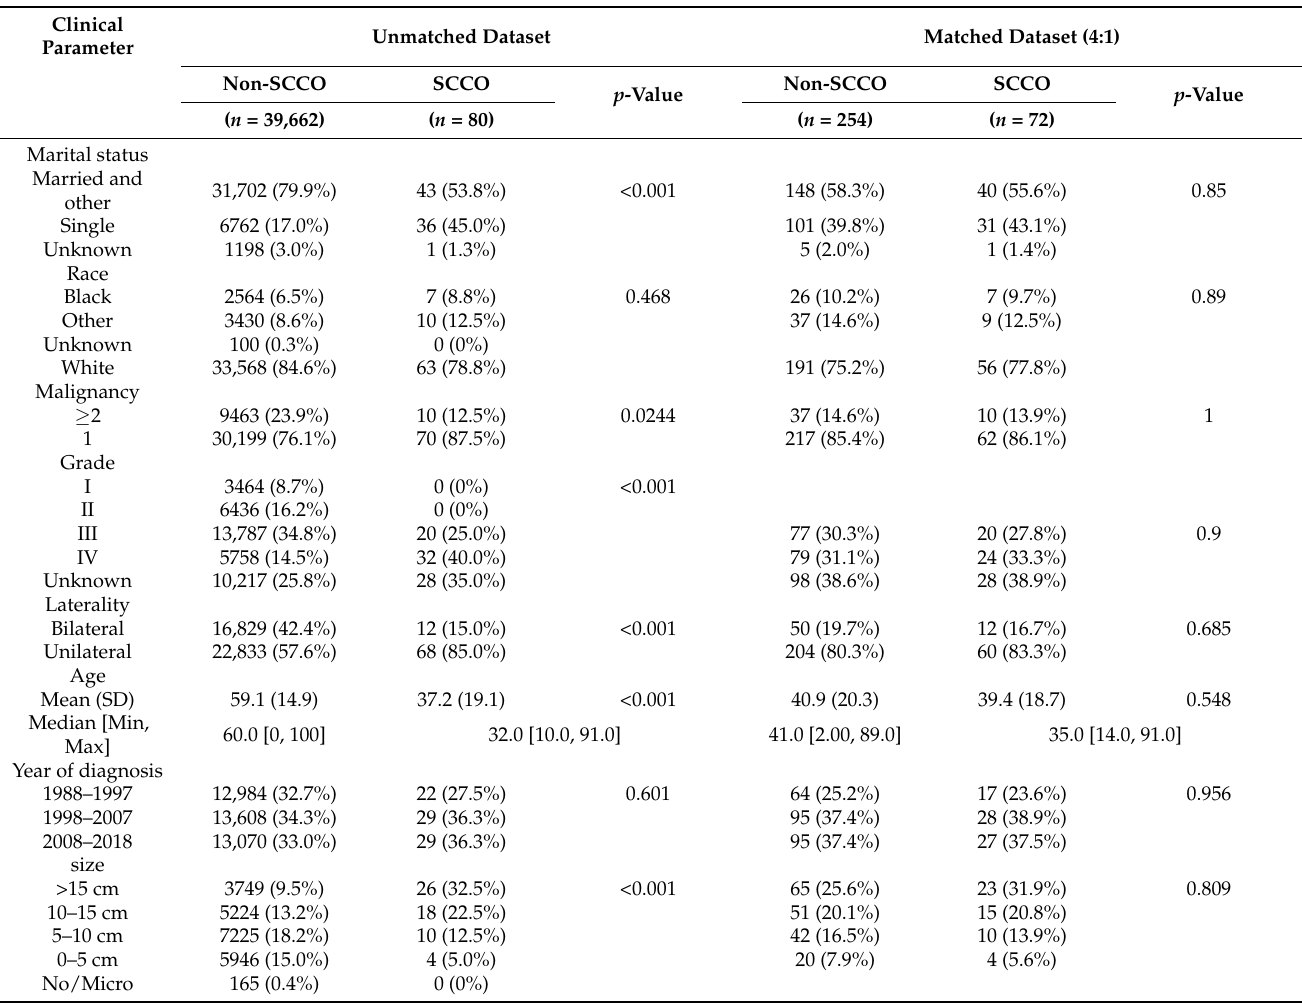
Table 1. Baseline demographic, clinicopathologic, and therapeutic characteristics for SCCO and non-SCCO before and after propensity